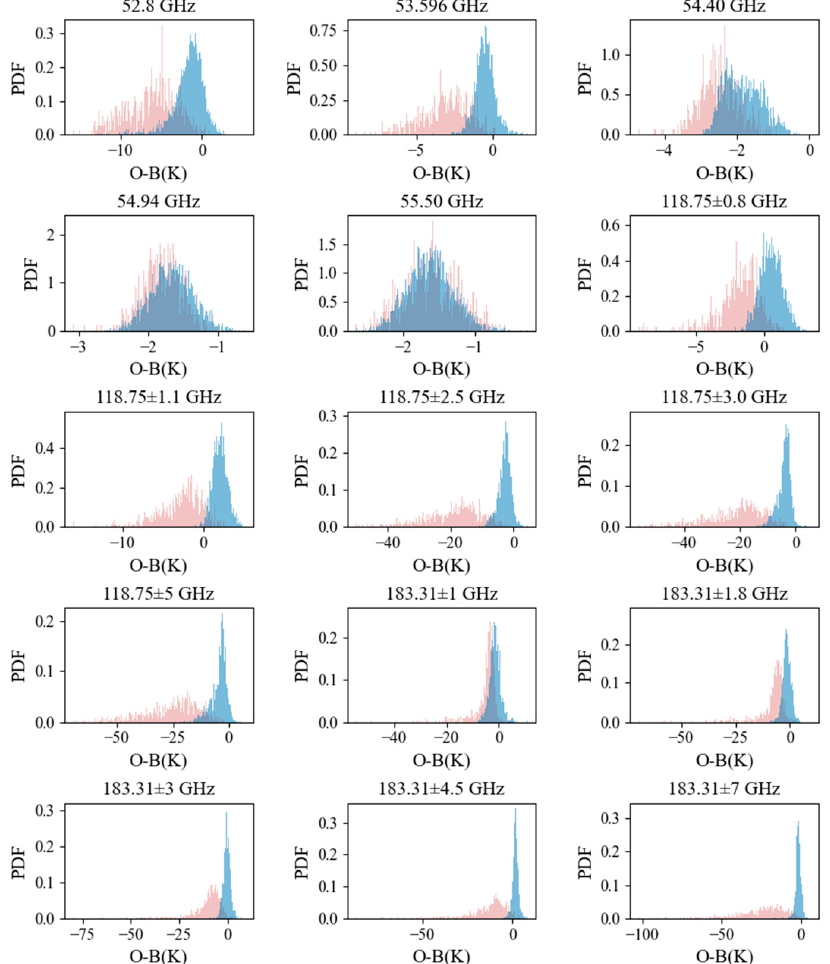
Figure 17. Same as Figure 16 except for the land surface.